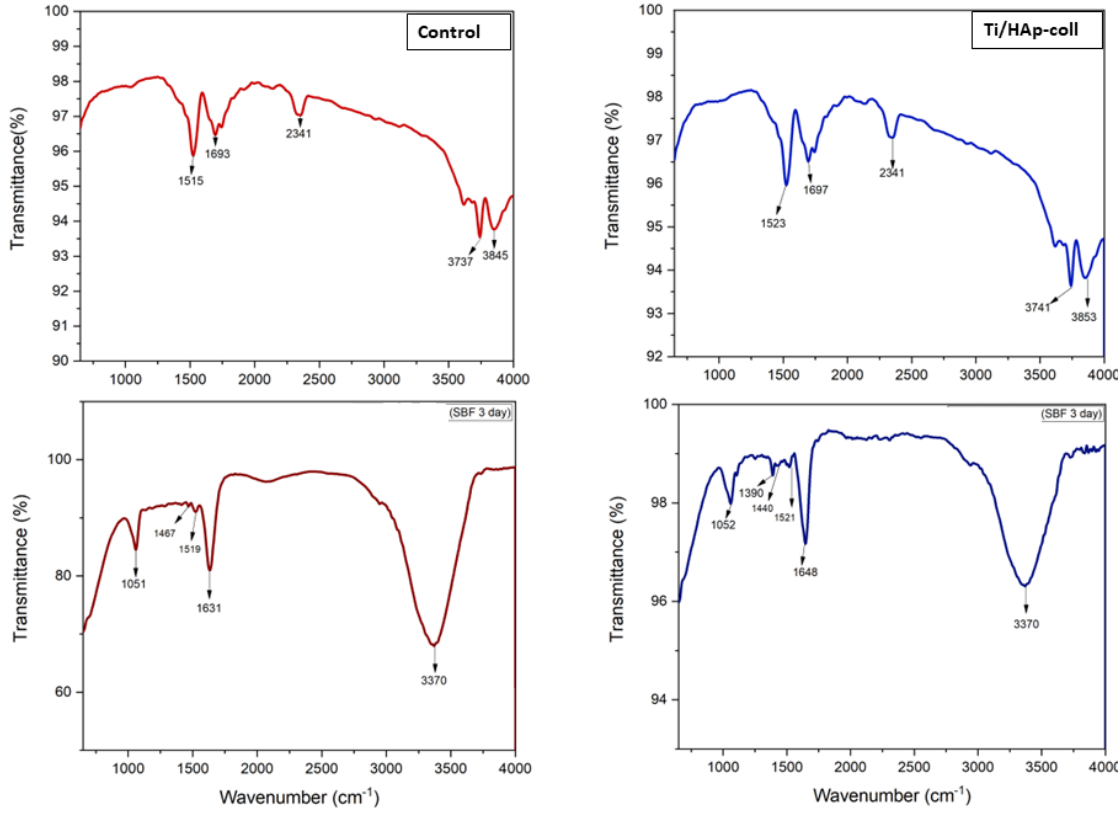
Figure 4. FTIR characteristics of Ti and Ti/HAp-coll substrate before and after SBF immersion (3 days).